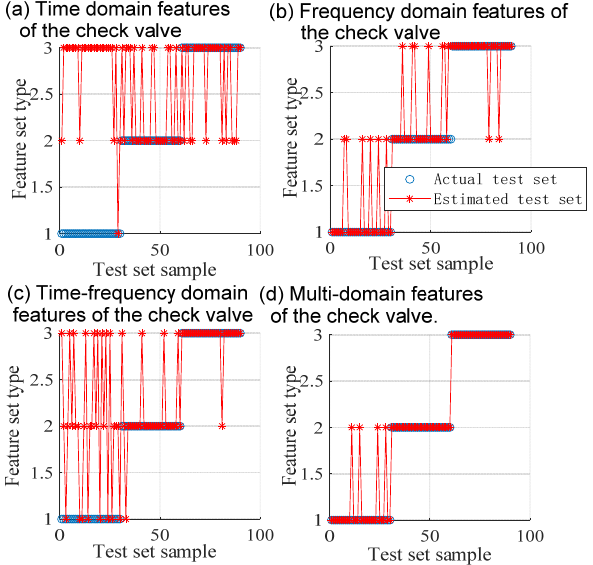
Figure 14. Comparison of diagnostic results for the time − domain, frequency − domain, time–frequency − domain, and multi − domain features of the check valve.